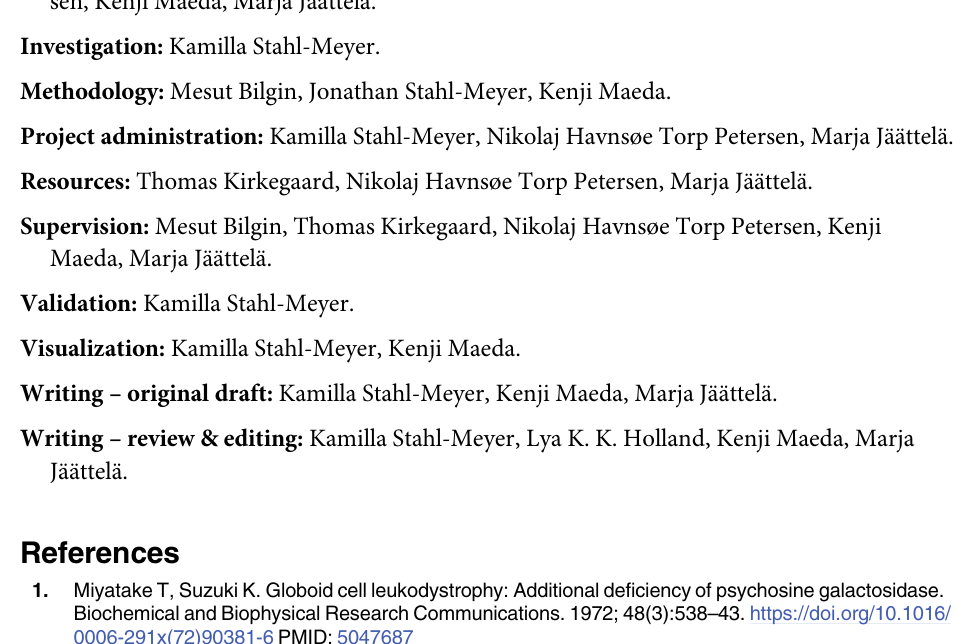
S3 Table. Table of siRNA. S4 Table. Internal lipid standards. S5 Table. Precursor ion, fragment ion and neutral loss for lipid identification. S6 Table. Quantities (mol%) of lipid species identified in GalSph- and GlcSph-treated MCF7 cells and their